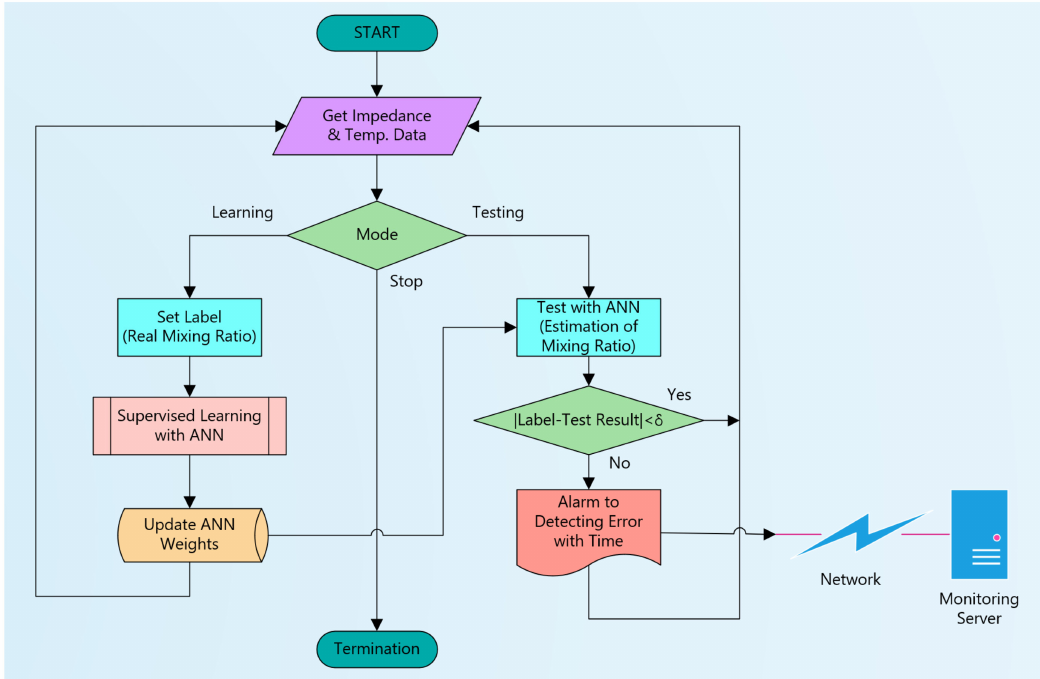
Figure 20. Suggested flow chart to configure for an online remote liquid monitoring